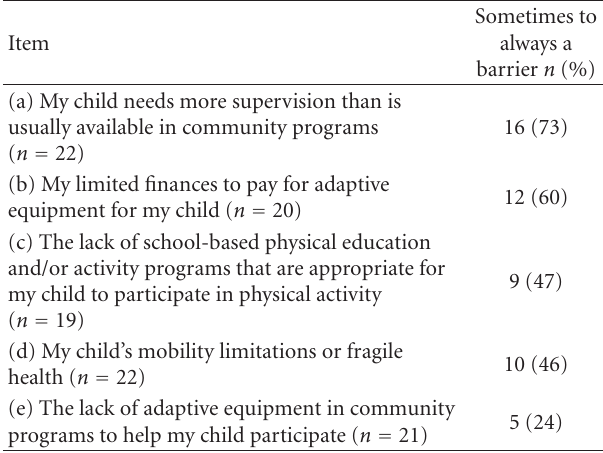
Table 5: Most common barriers to physical